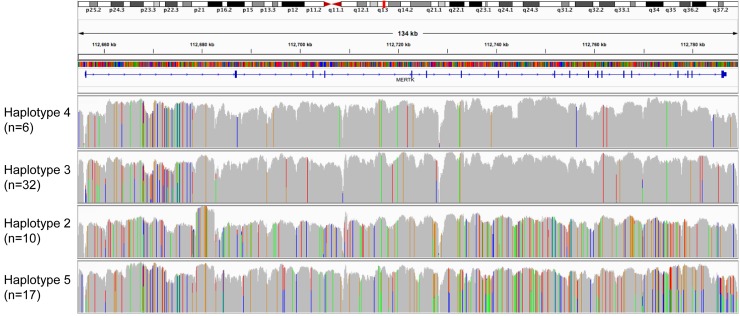
Heat map of variants found in MERTK grouped according to haplotype.The sequence of each group following resequencing was compared with the reference genome (GRCh37/hg19). Coloured lines indicate a base that is variant compared with the reference genome. Mapping of the groups shows that haplotype groups 3 and 4 were most closely related to the reference sequence, showing many invariant nucleotides. Conversely haplotype groups 2 and 5 showed the greatest differences to the reference sequence and an apparently close relationship, sharing many variants.